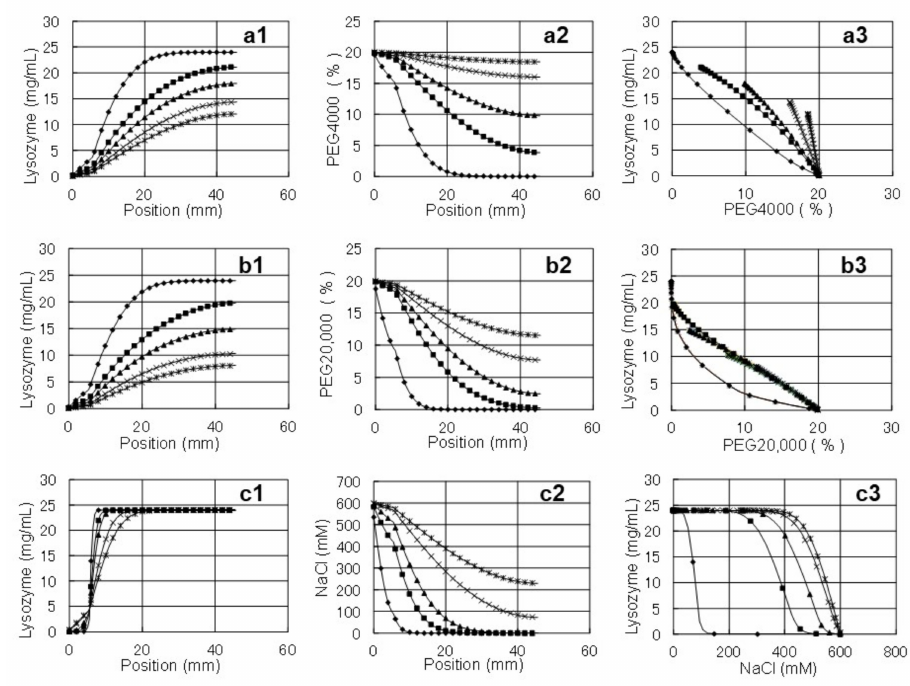
Figure 6. Calculated results of the di ff usion processes in the crystallization chamber with 1D simulation. The results of repetitive calculation of Equations (14)–(18) are shown. The crystallization chamber is assumed to be a 6 mm length and 1 mm bore gel tube and 0.5 mm bore glass capillary with a 40 mm length protein solution; ( a ) 24 mg / mL of lysozyme is loaded into the capillary and 20% of PEG4000 is applied as the precipitant for the reservoir solution; ( b ) 24 mg / mL of lysozyme and 20% of PEG20,000; ( c ) 24 mg / mL of lysozyme with 20% of PEG20,000 is loaded into the capillary, 20% of PEG20,000 is presoaked in the gel tube and 20% of PEG20,000 and 600 mM of NaCl is applied as the precipitant for the reservoir solution. The protein concentrations along the chamber are shown in ( a1 , b1 , c1 ). The abscissa shows the position along the chamber from the open end of the gel tube. The concentrations of the precipitant along the chamber are shown in ( a2 , b2 , c2 ). The concentration relations of the precipitant and the protein along the chamber are plotted in ( a3 , b3 , c3 ). For ( a , b ), (cid:95) , (cid:4) , (cid:78) , × , Ж show the values of 4, 32, 64, 128 and 192 days after the starting of the di ff usion, respectively. For ( c ), they show the values of 0.2, 1, 2, 8 and 16 days, respectively. The values are plotted every 2 mm along the